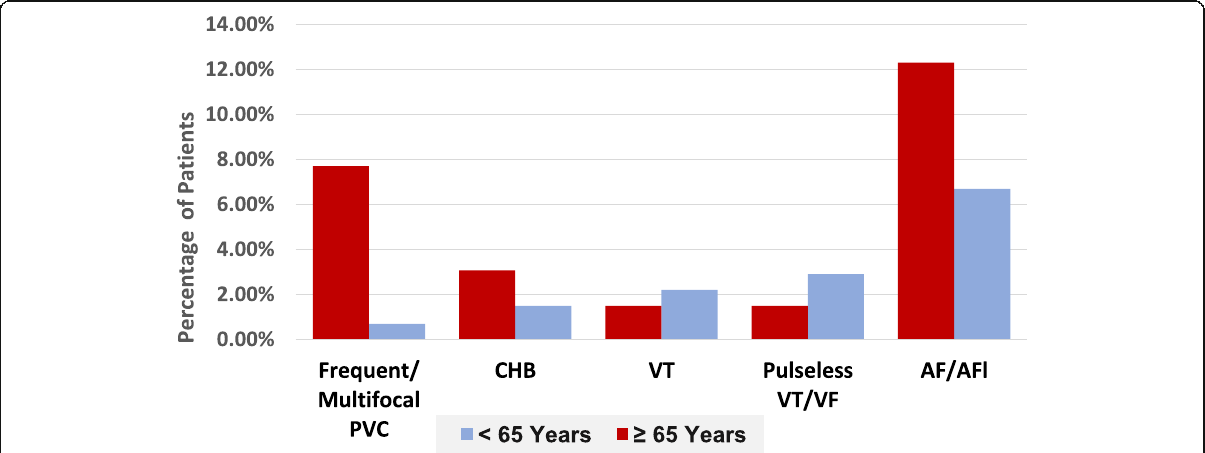
Fig. 4 Distribution of arrhythmias in NSTE-ACS according to age category. Patients who had more than one type of arrhythmia recorded within each type separately